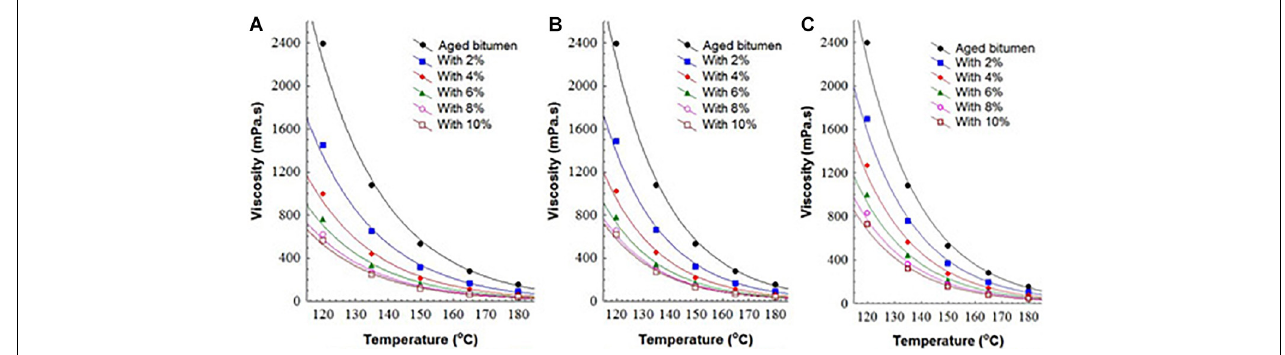
FIGURE 6 | Viscosity of recovered bitumen with C, S, and M rejuvenators at different temperature. (A) Rejuvenator C (based on corn oil). (B) Rejuvenator S (based on soybean oil). (C) Rejuvenator M (based on fuel oil).